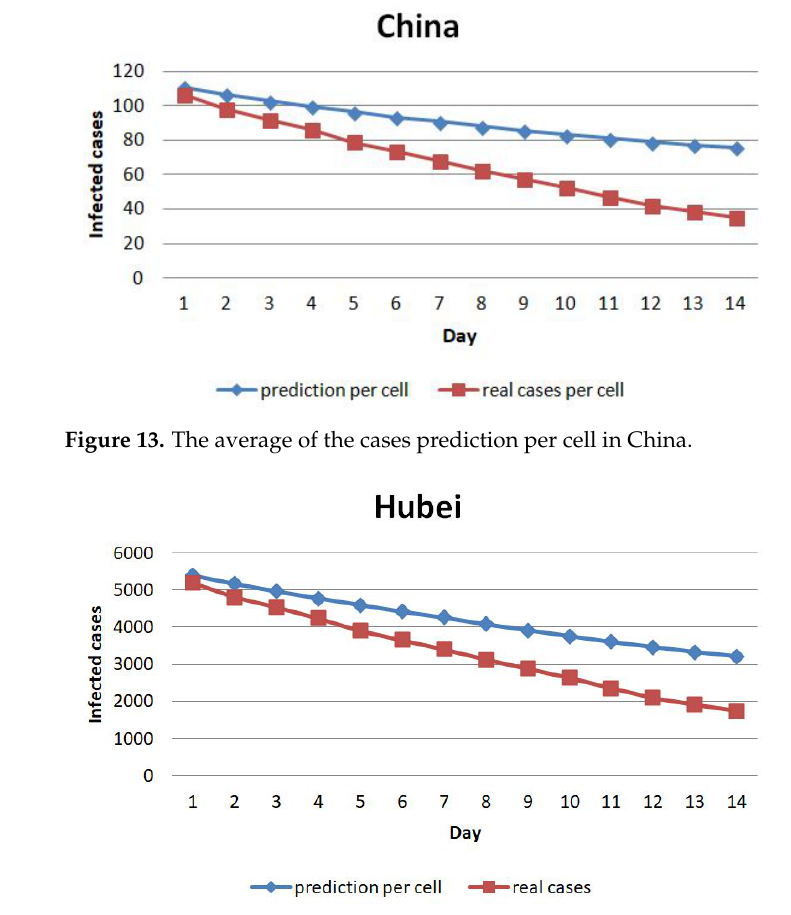
Figure 14. The average of the cases prediction per cell for Hubei.